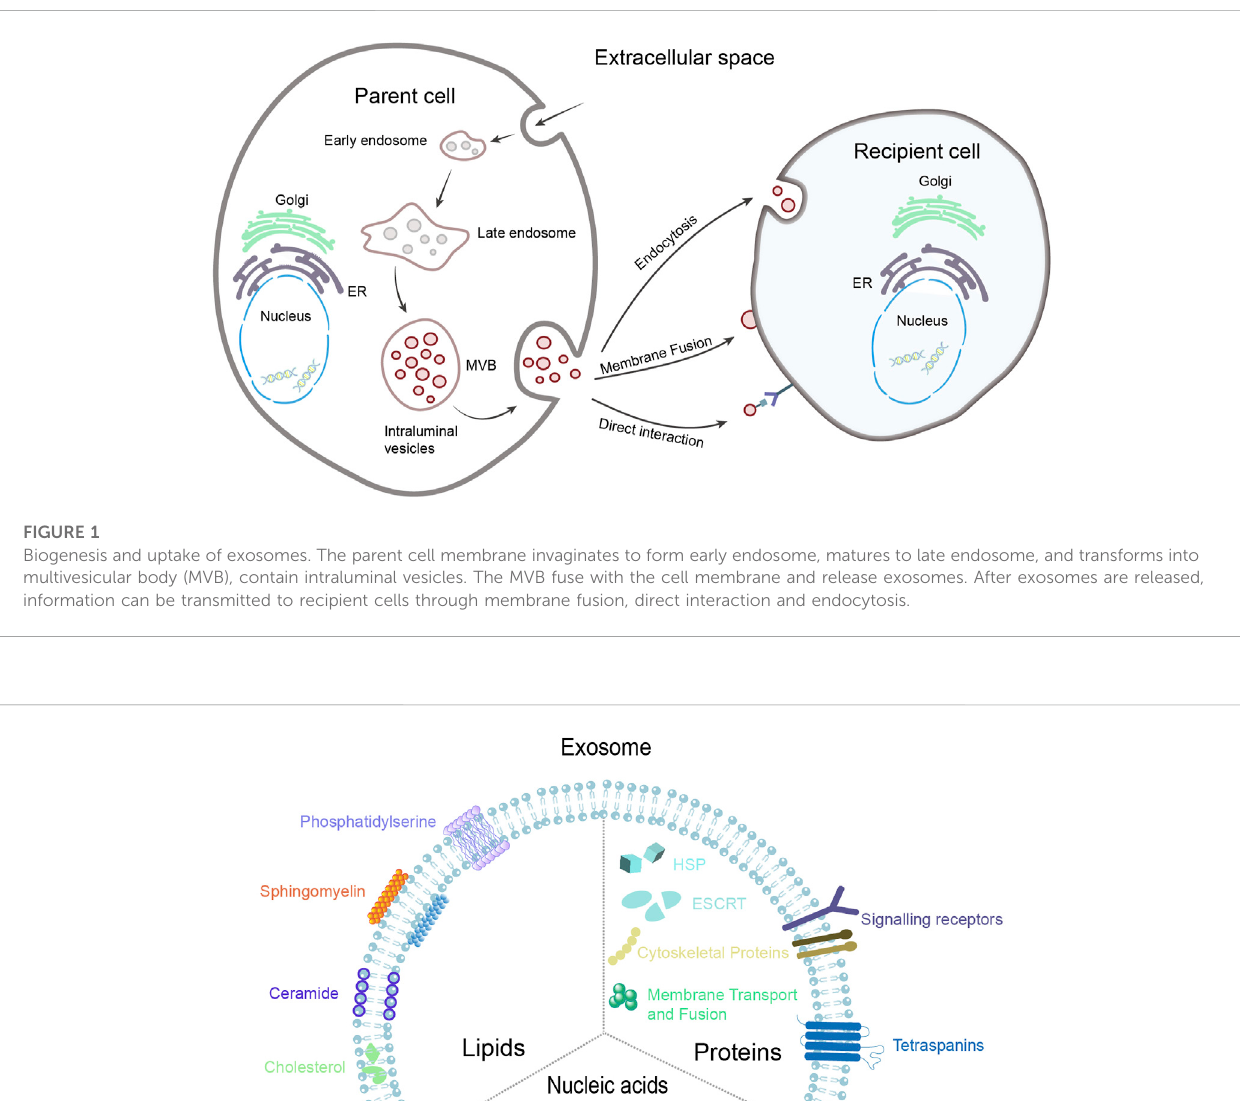
Frontiers in Bioengineering and